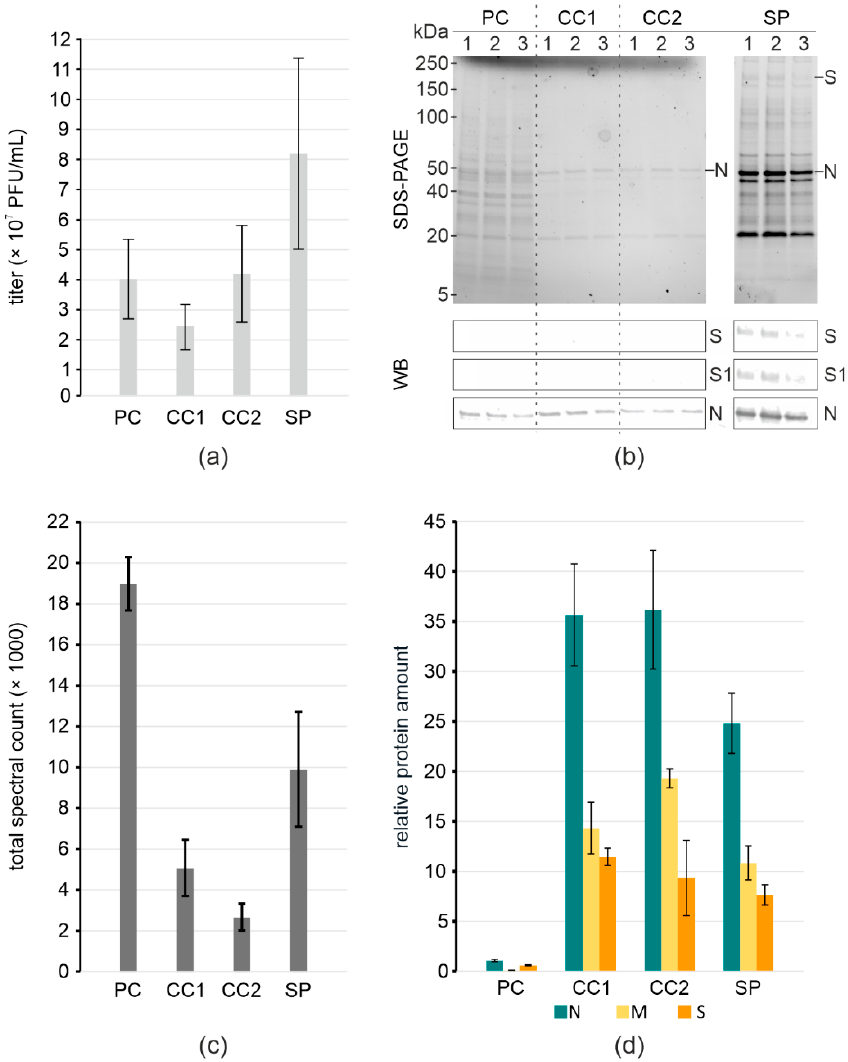
Figure 1. Virus yield and purity at different purification steps. ( a ) Virus titers; ( b) SDS-PAGE of total protein content and WB of S and N in samples. Molecular weight markers are indicated on the left; ( c ) Total spectral counts of peptides detected in samples; ( d ) Relative protein amount in samples normalized to ORF9b. ( a – d ) pre-cleared stock (PC), Capto Core 1× (CC1), Capto Core 2× (CC2); pel- leting through 20% sucrose (SP).